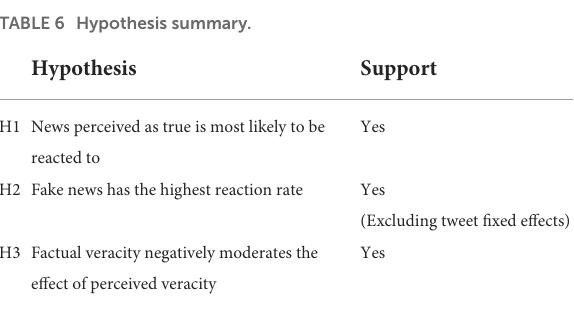
TABLE 6 Hypothesis